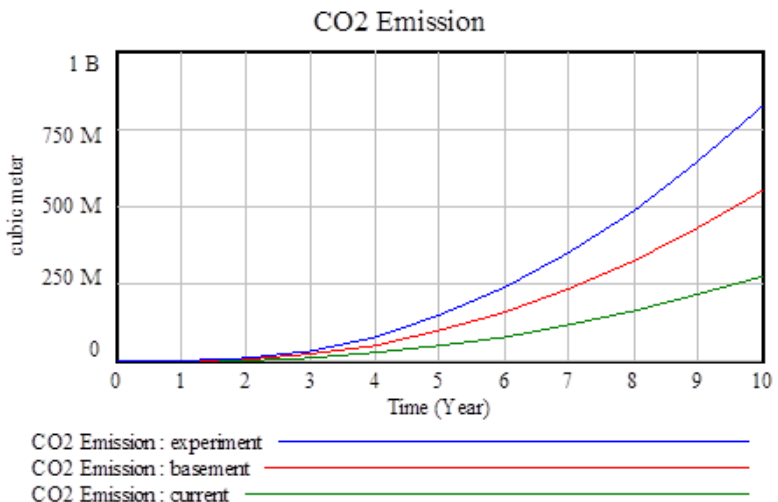
Figure 8. Experiment for CO 2 emission with changes of